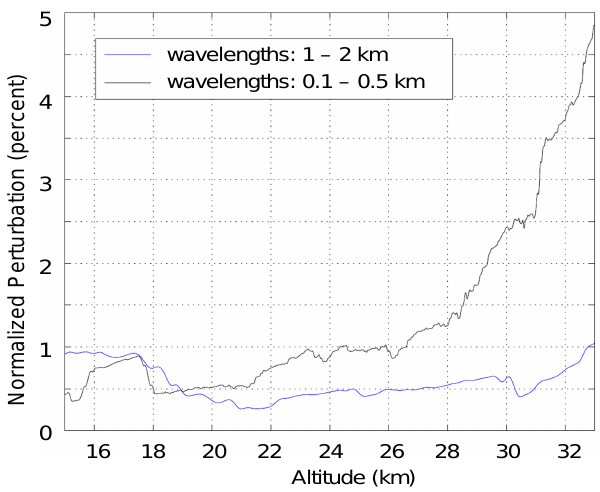
Fig. 8. Height variations of normalized fluctuations of the bending angle for height scales of 1–2km (blue line) and 0.1–0.5km (black line).